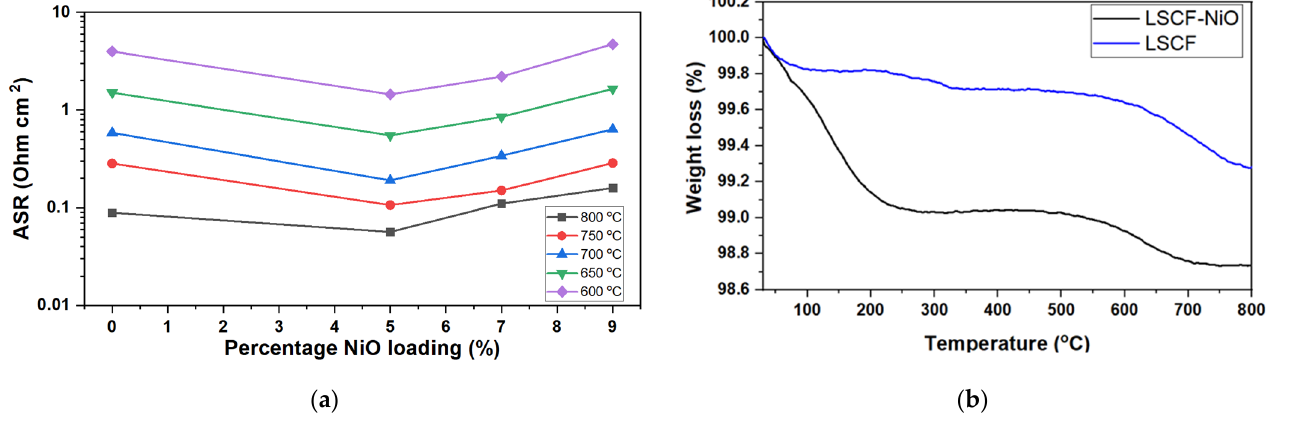
Figure 3. ( a ) Effect of varies nickel oxide loading content on LSCF cathode towards the area specific resistance (ASR) of the symmetric cell. ( b ) Thermal analysis of bare LSCF vs. LSCF with 5 wt% NiO powder from room temperature to 800 °C.